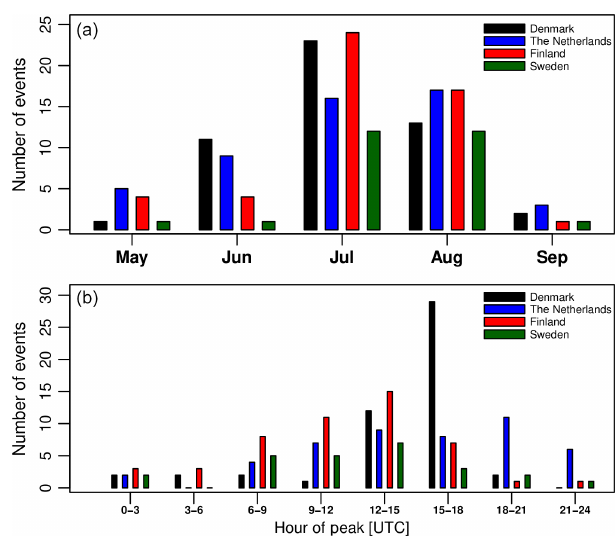
Figure 3. Distribution of the 50 top events over the month (a) and hour of the day (b)